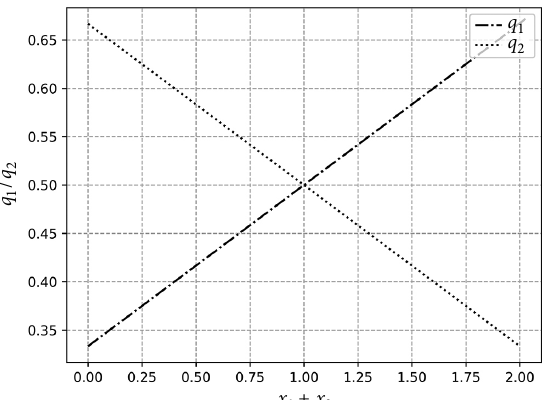
x 1 + x Figure 1. Evolution of market share gained by developers 1 and 2